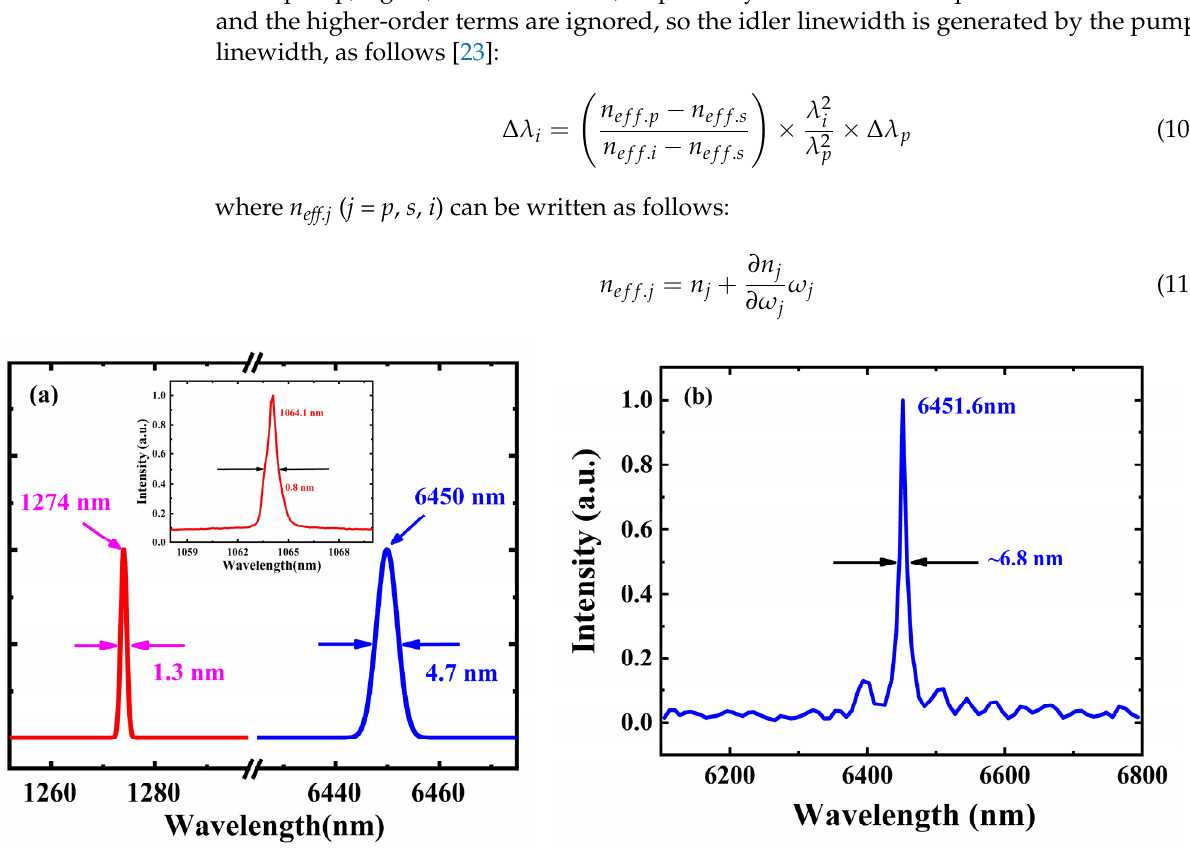
Figure 6. Measured and simulated spectra of the pump, signal, and idler beams in BGSe-OPO. ( a ) Simulation of signal and idler laser wavelength and linewidth. The inset at the top: the measured pump spectrum at 1064 nm. ( b ) Measured spectrum of output idler beam.